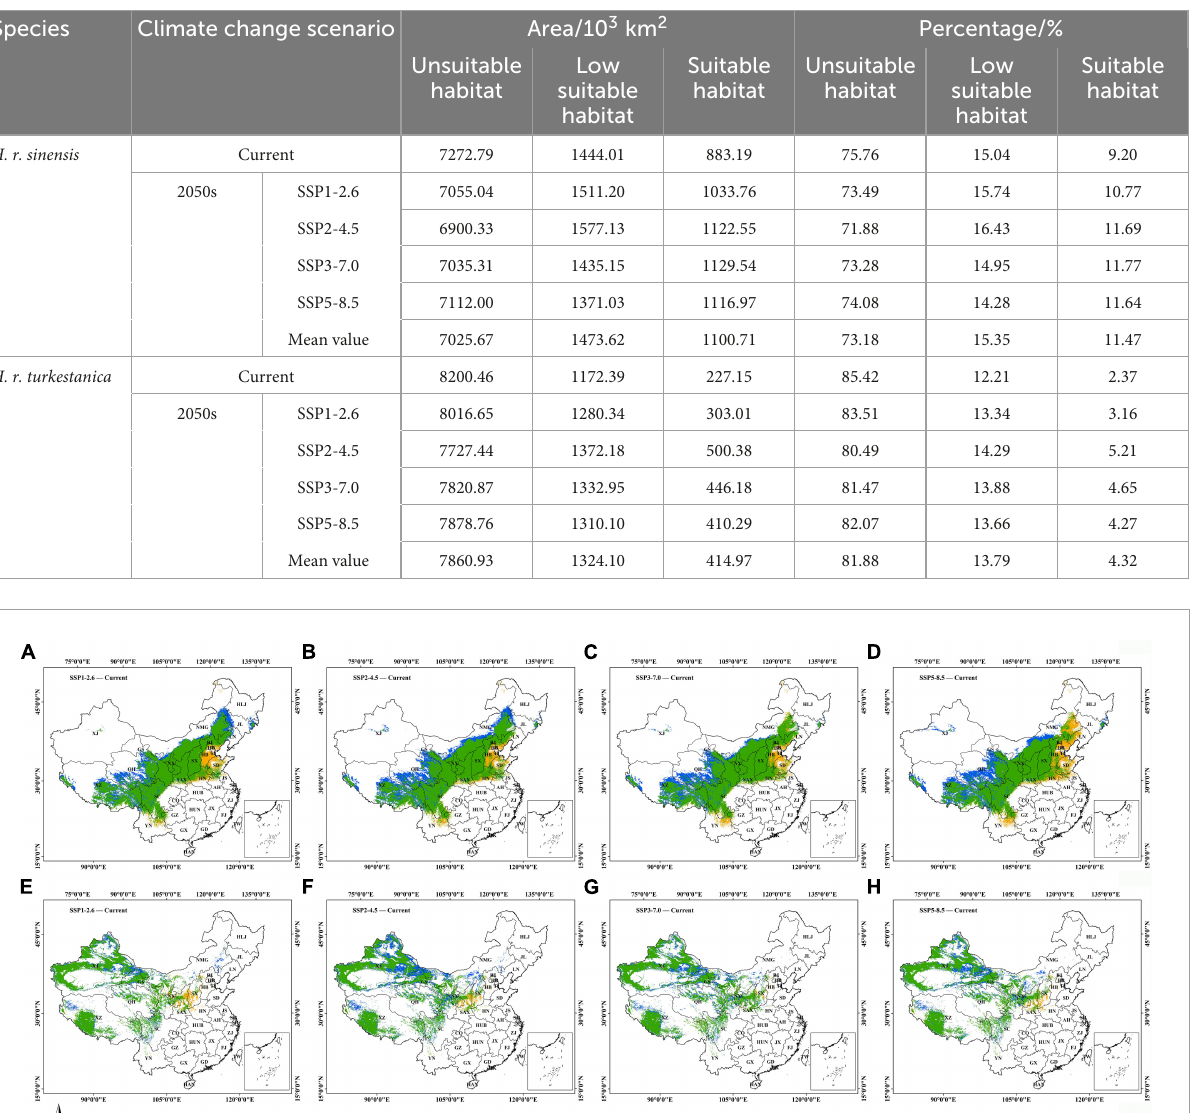
TABLE 3 Area and percentage of the suitable habitat of these two subspecies belonging to class three under the different climatic scenarios. Species Climate change